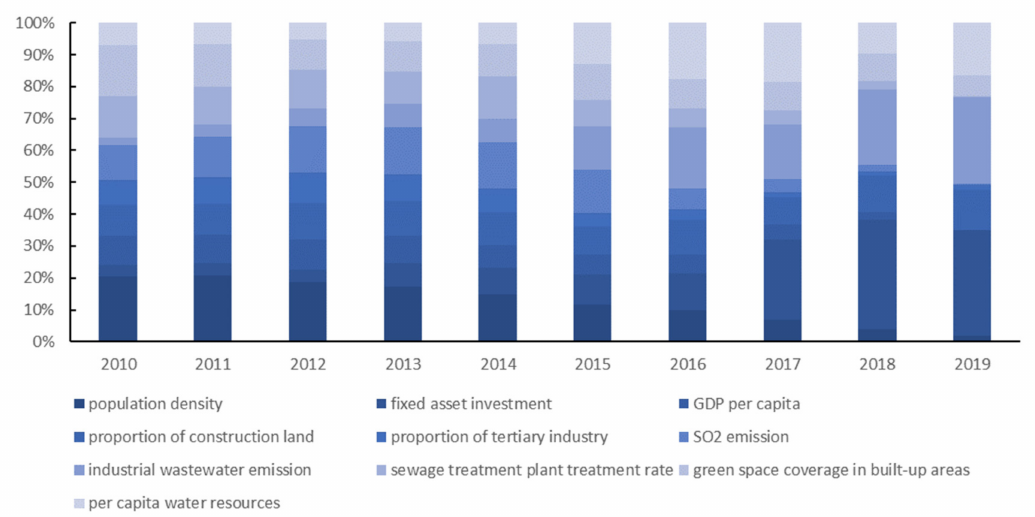
Figure 11. Degrees of the factors constraining coupled coordination of economic and ecological development in the Yellow River basin